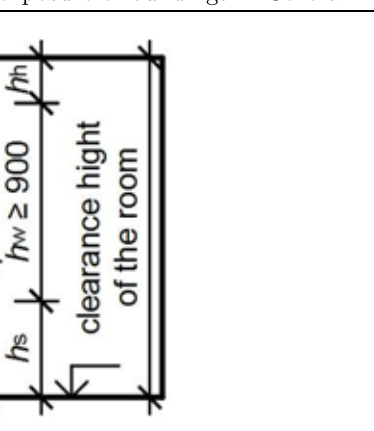
s is height of the window sill, h w is height of